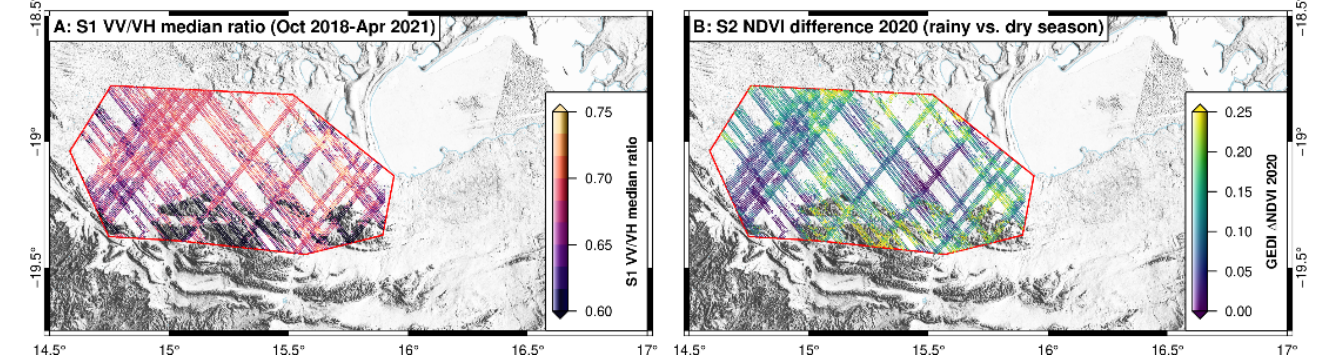
Figure 3. ( A ) Sentinel 1 median polarization ratio (VV/VH) averaged from October 2018 to April 2021 extracted for ATL03 and GEDI locations (only GEDI locations are shown here). Polarization ratios indicate the amount of depolarization usually associated with scattering on vegetation, especially trees. ( B ) Sentinel 2 NDVI differences between the rainy and dry season of 2020. The full S1 polarization ratio (VV/VH) coverage is shown in Figure